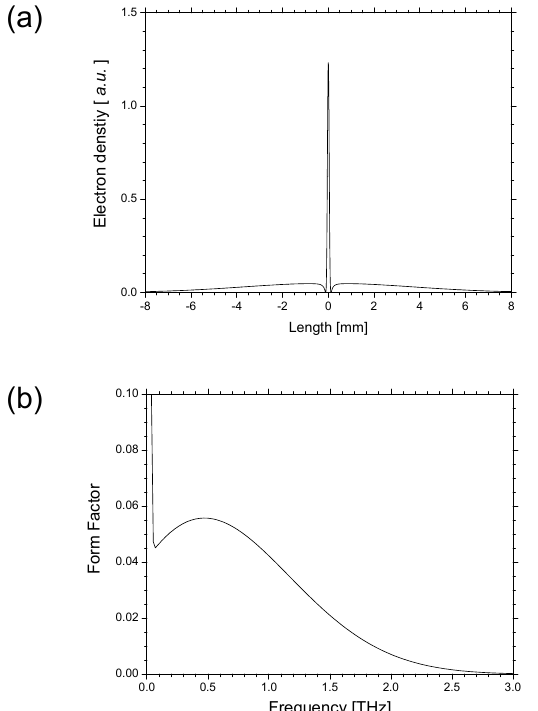
Figure 6. ( a ) Electron distribution based on a pseudo-Voigt function with w V = 90 μm and η = −0.8. The area and standard deviation of the additional Gaussian distribution are 5.4 and 100 times the Gaussian distributions that constitute the pseud-Voigt function, respectively. ( b ) Form factor spectrum calculated for the electron distribution in ( a ).